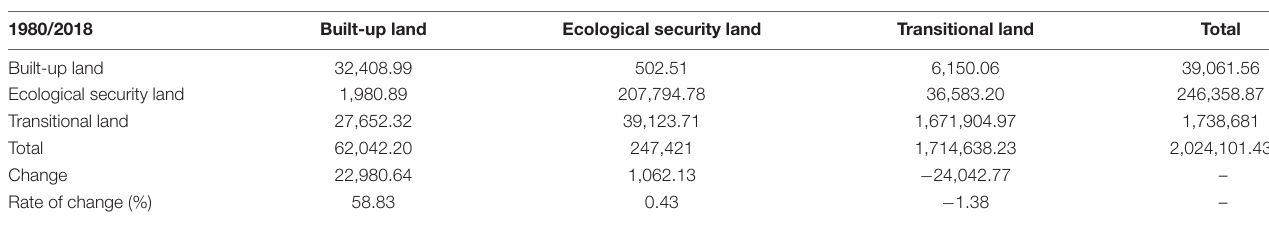
TABLE 3 | Land-use changes in the Yellow River Basin, 1980–2018 (km 2